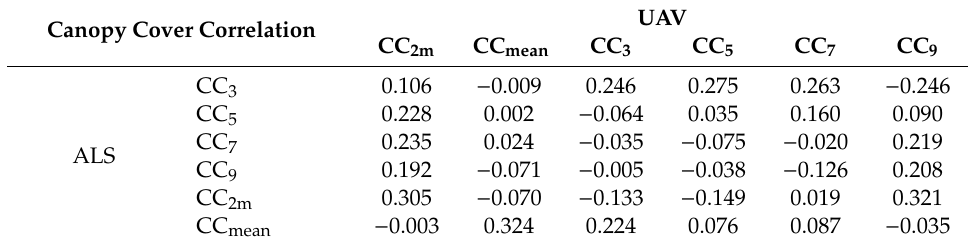
Table 5. Correlations between UAV and ALS canopy cover density point clouds. Canopy Cover